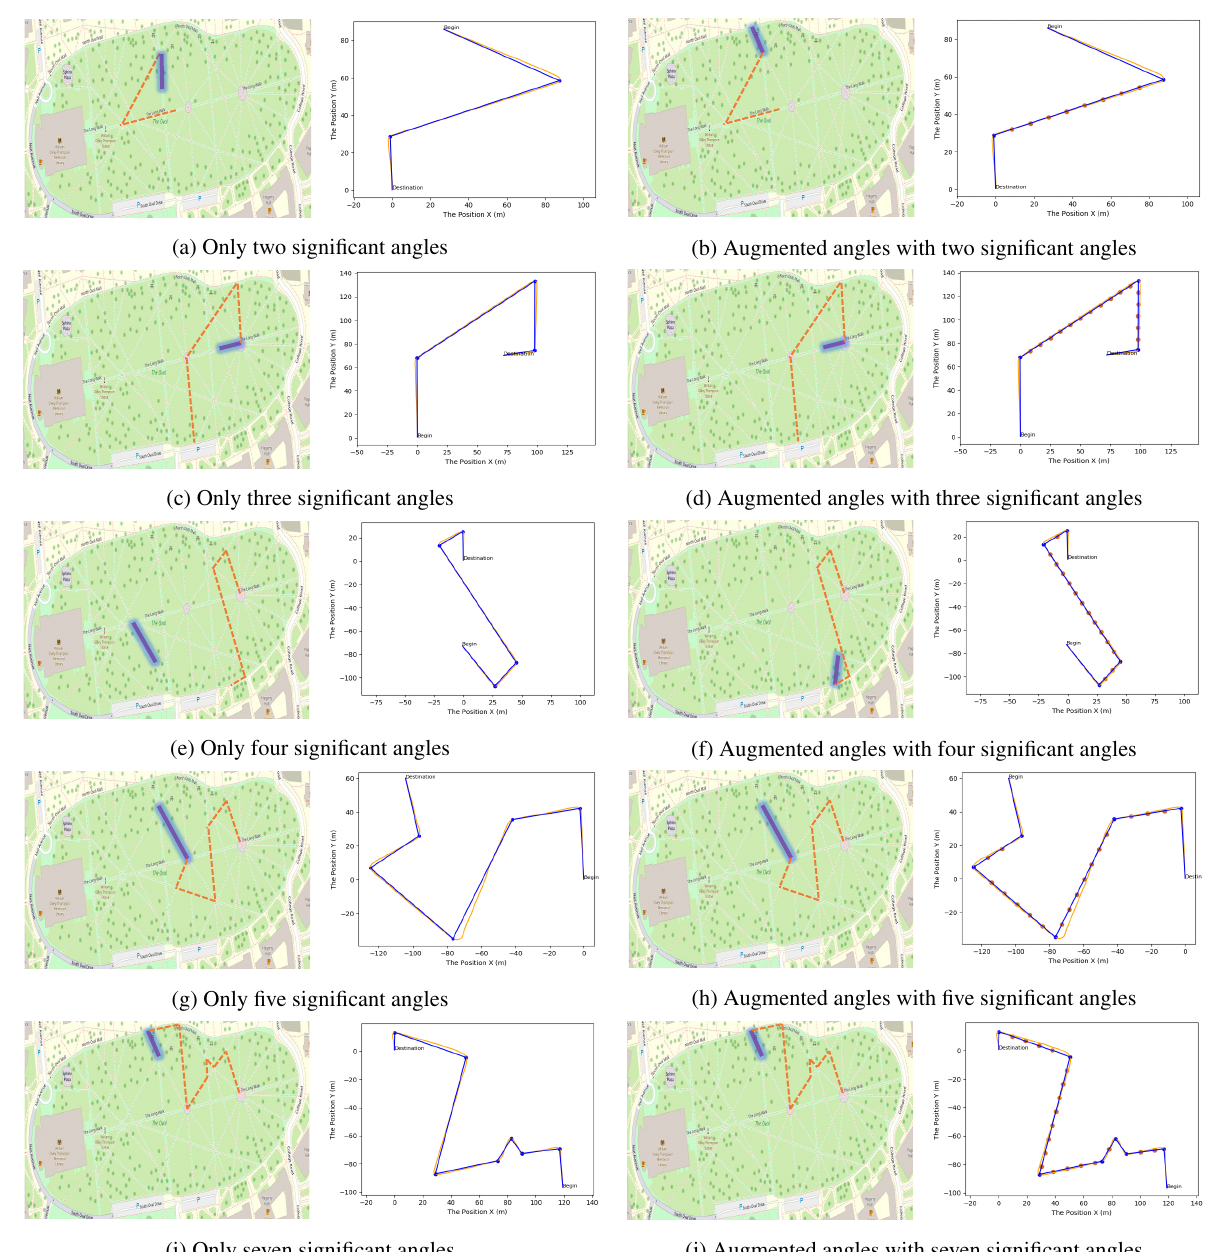
Figure 14. Five different real trajectories localization example with only significant angle case (left side) and augmented case (right side). The number of significant turning angles from (a) to (e) are 2, 3, 4, 5, 7. The orange and blue line are raw VIO trajectory and line segment simplification result, respectively. The glory line in the map indicates location edge